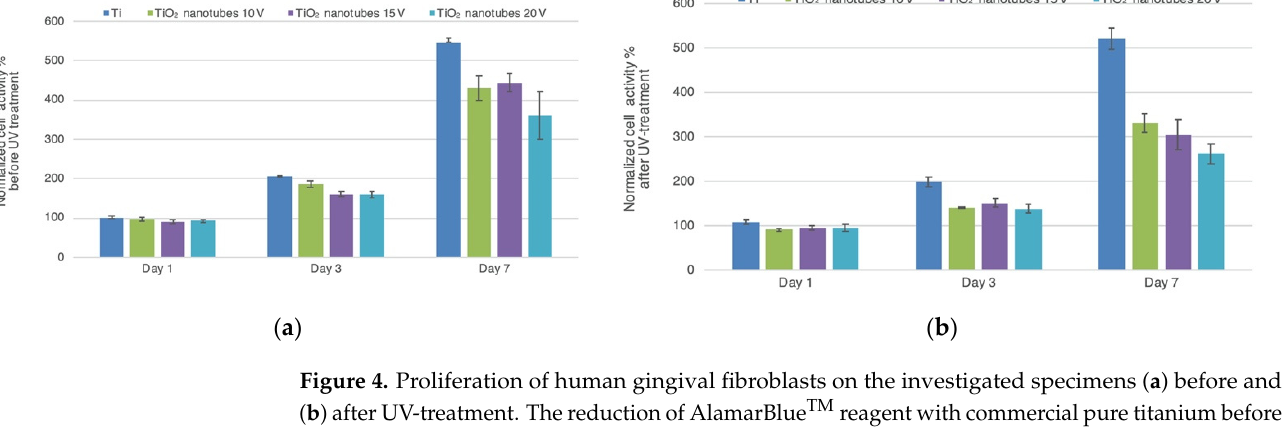
Figure 3. The amount of S. mutans biofilm formation on the experimental specimens before and after UV treatment. Data are presented as mean ± standard deviation ( n = 4). UV treatment caused statistically significant decreases in biofilm formation only for 10 V and 20 V TiO 2 nanotubes.